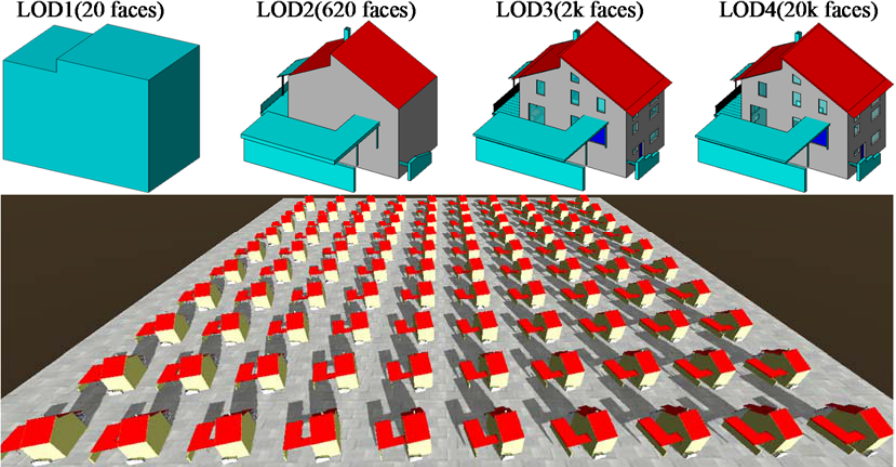
Figure 8. Level of details of a CityGML building model.